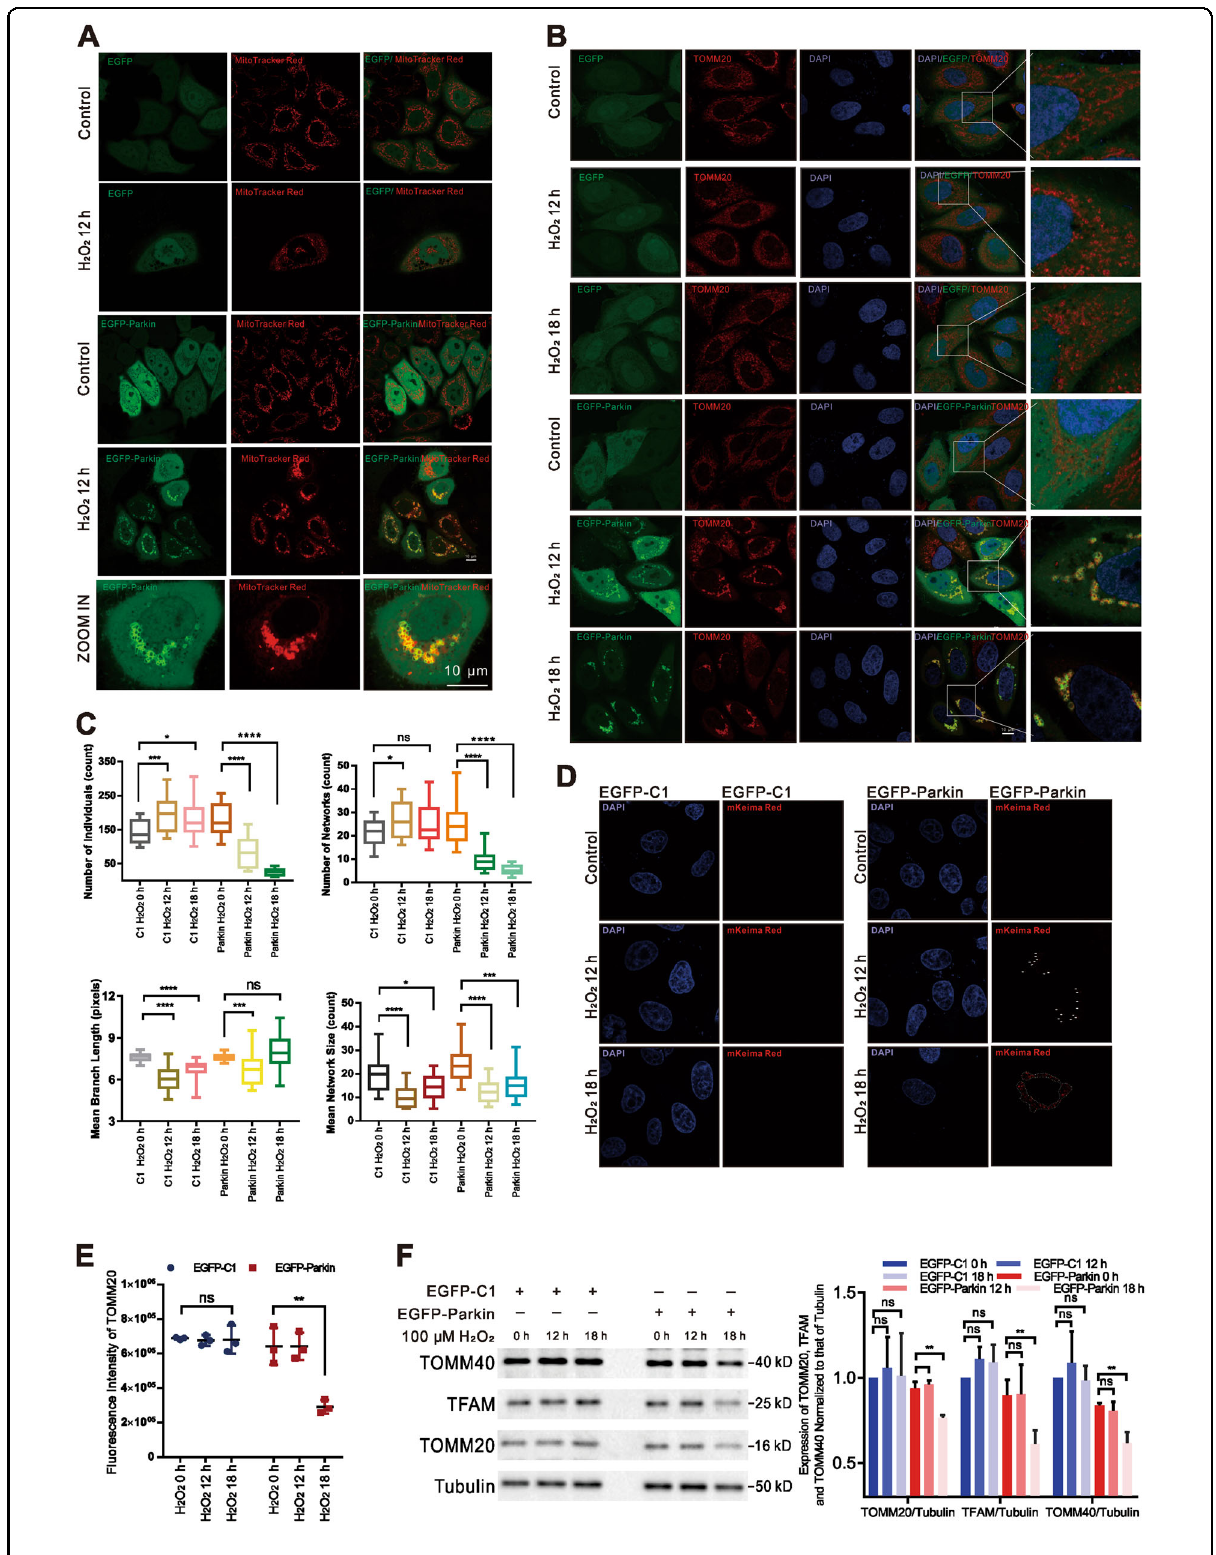
Fig. 1 (See legend on next